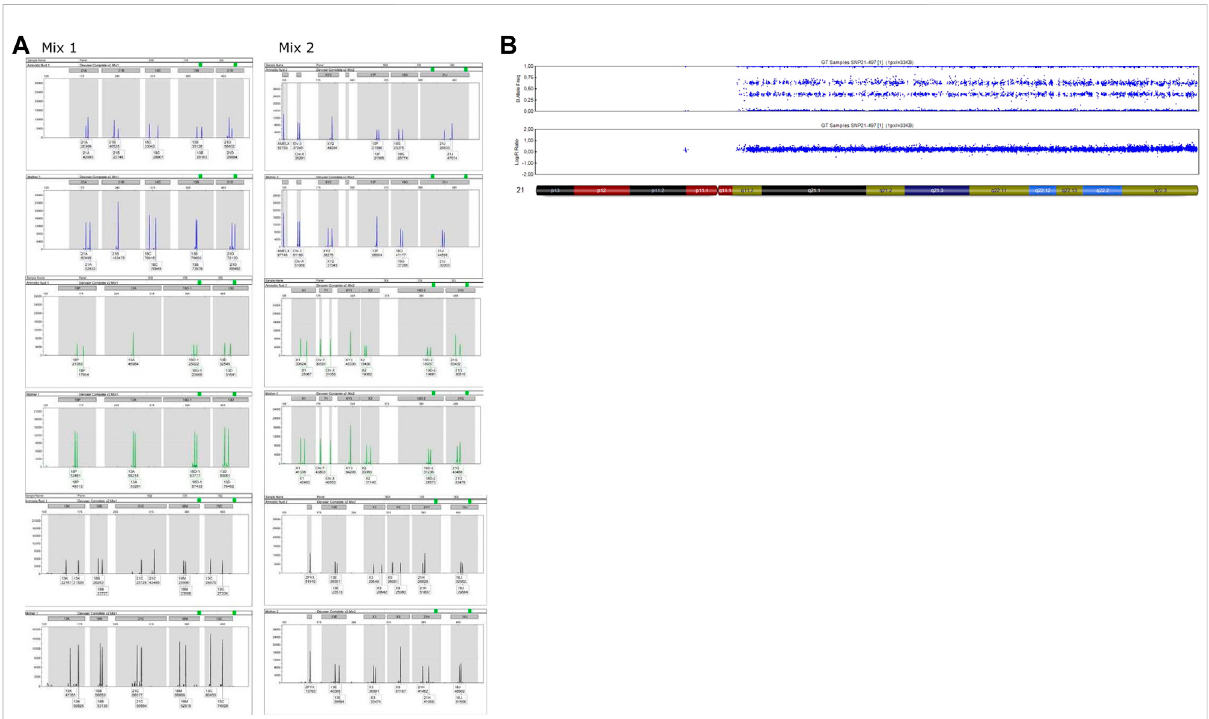
FIGURE 1 Analysesperformedonamniotic fl uidofCase1. (A) QF-PCRresults.Foreachchannel,the fi rstlanerepresentstheamniotic fl uidandthesecond is the maternal blood sample. Markers 21A, 21B, 21D and 21C show a complete T21. (B) SNP-array results. Complete